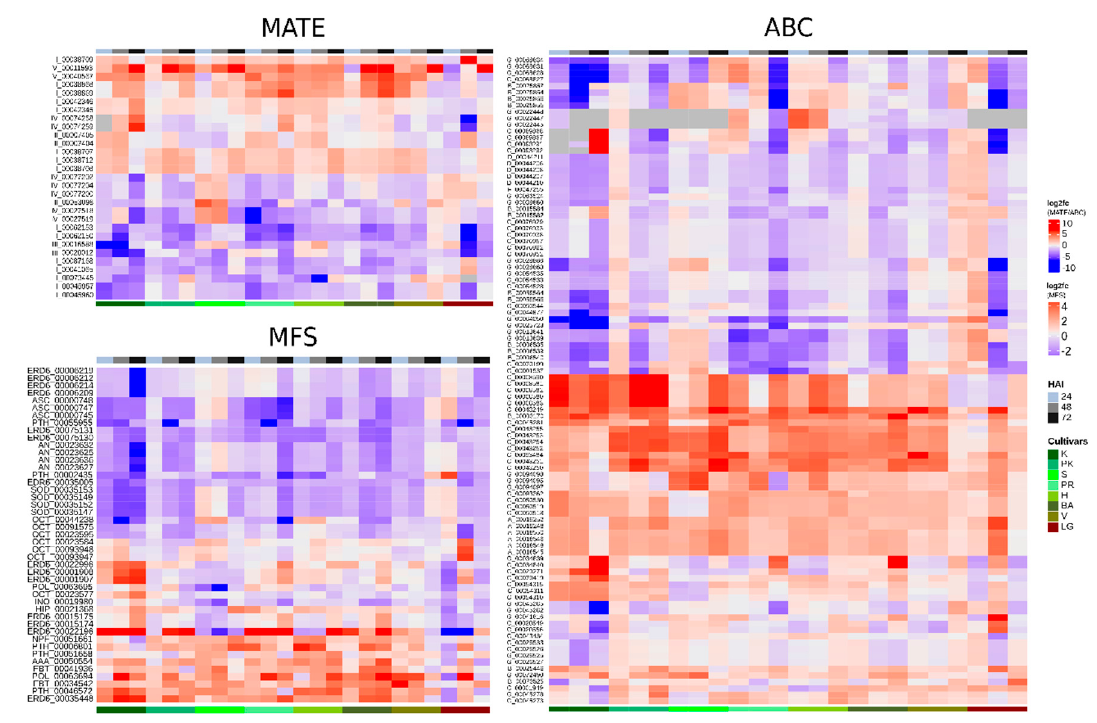
Figure 6. Heatmap of expression profiles of MATE, ABC, and MFS transcripts differentially expressed on at least one hours after bacterial inoculation (HAI) in a species. K: ‘Kumquat’, PK: ‘Ponkan’, S: ‘Satsuma’, PR: ‘Pera Rio’, H: ‘Hamlin’, BA: ‘Bahia’, V: ‘Valencia’, and LG: ‘Galego’. The identification of each transcript is given by the abbreviation of its respective subfamily followed by its identification number in the CRT (Figure S4 show the clusterized heatmap).